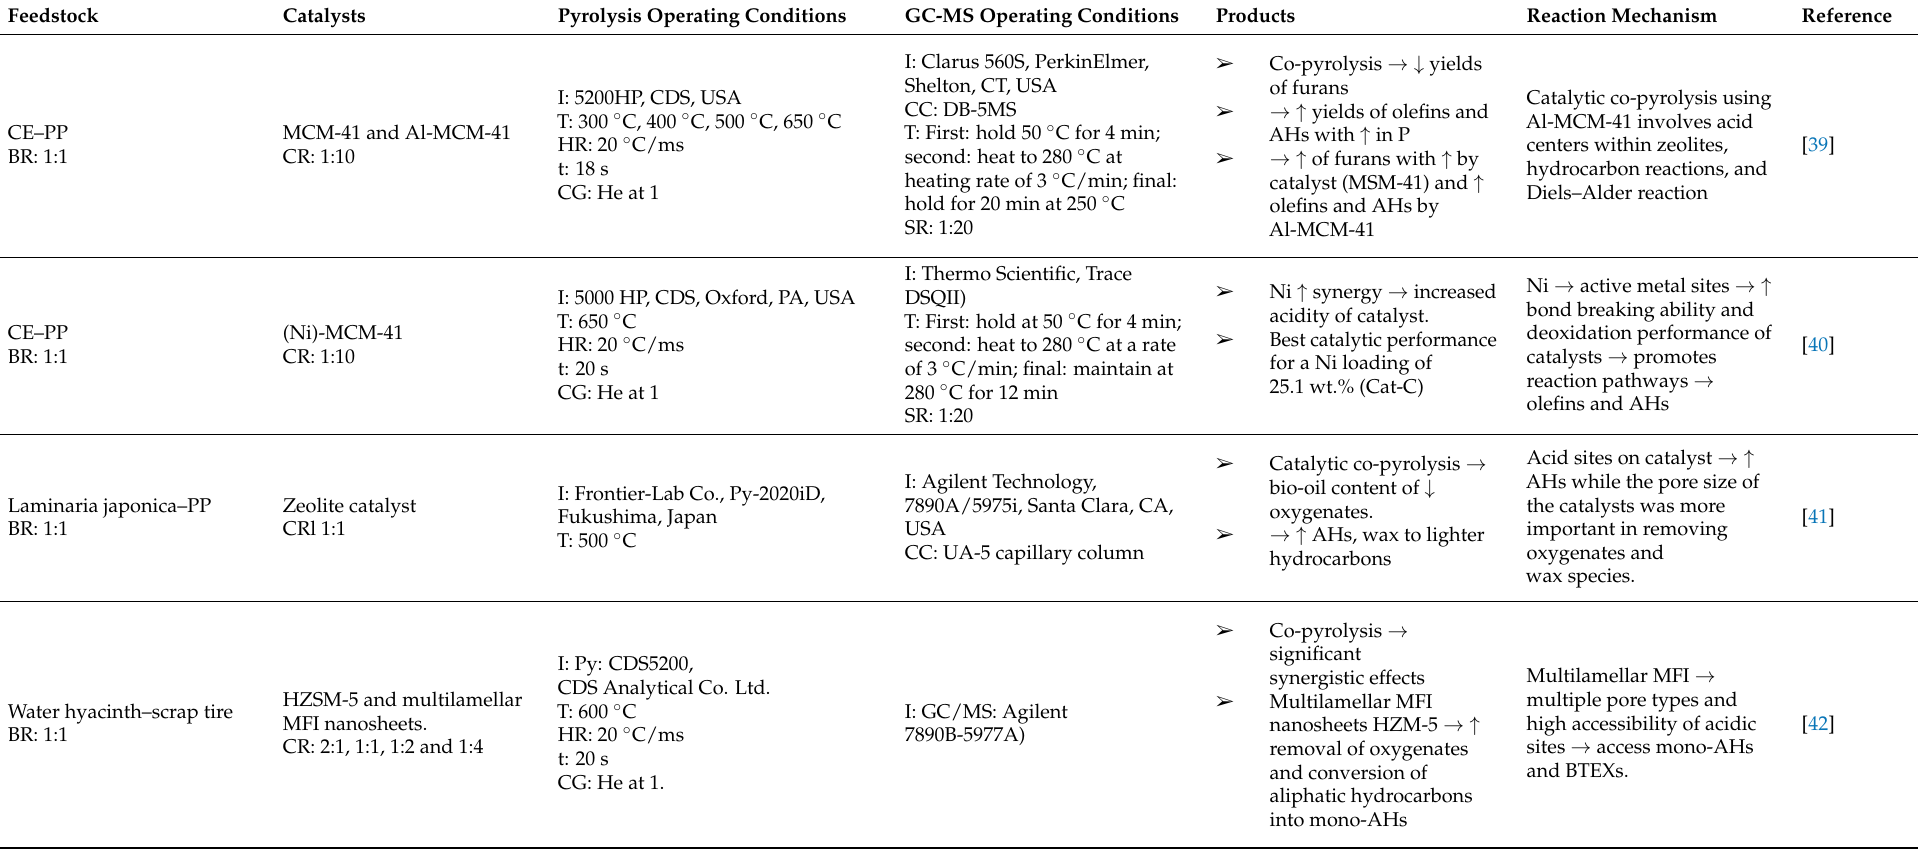
Catalysts Pyrolysis Operating Conditions GC-MS Operating Conditions Products Reaction Mechanism